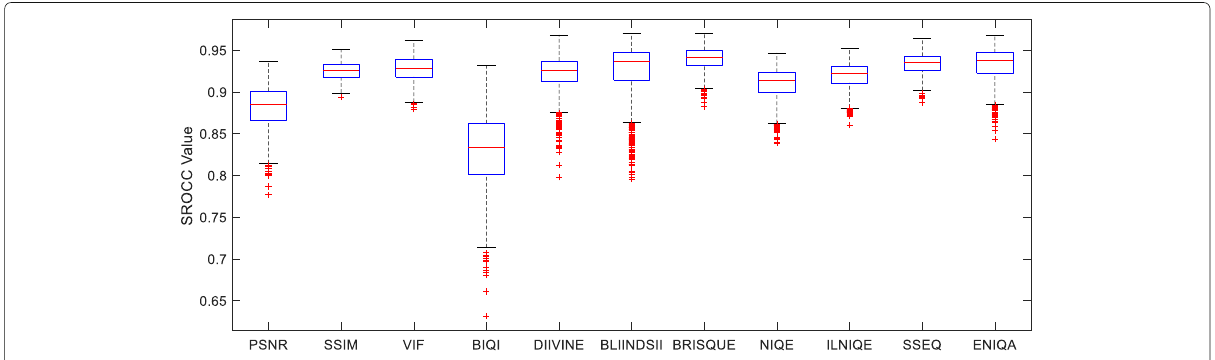
Fig. 6 Box plot of SROCC distributions of the compared IQA methods over 1000 trials on the LIVE database